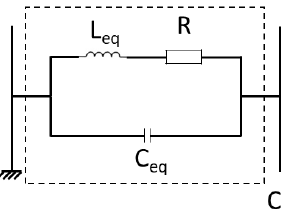
Figure 7. Equivalent electronic model proposed by Jian et al. [9] for one element of the EMAT.